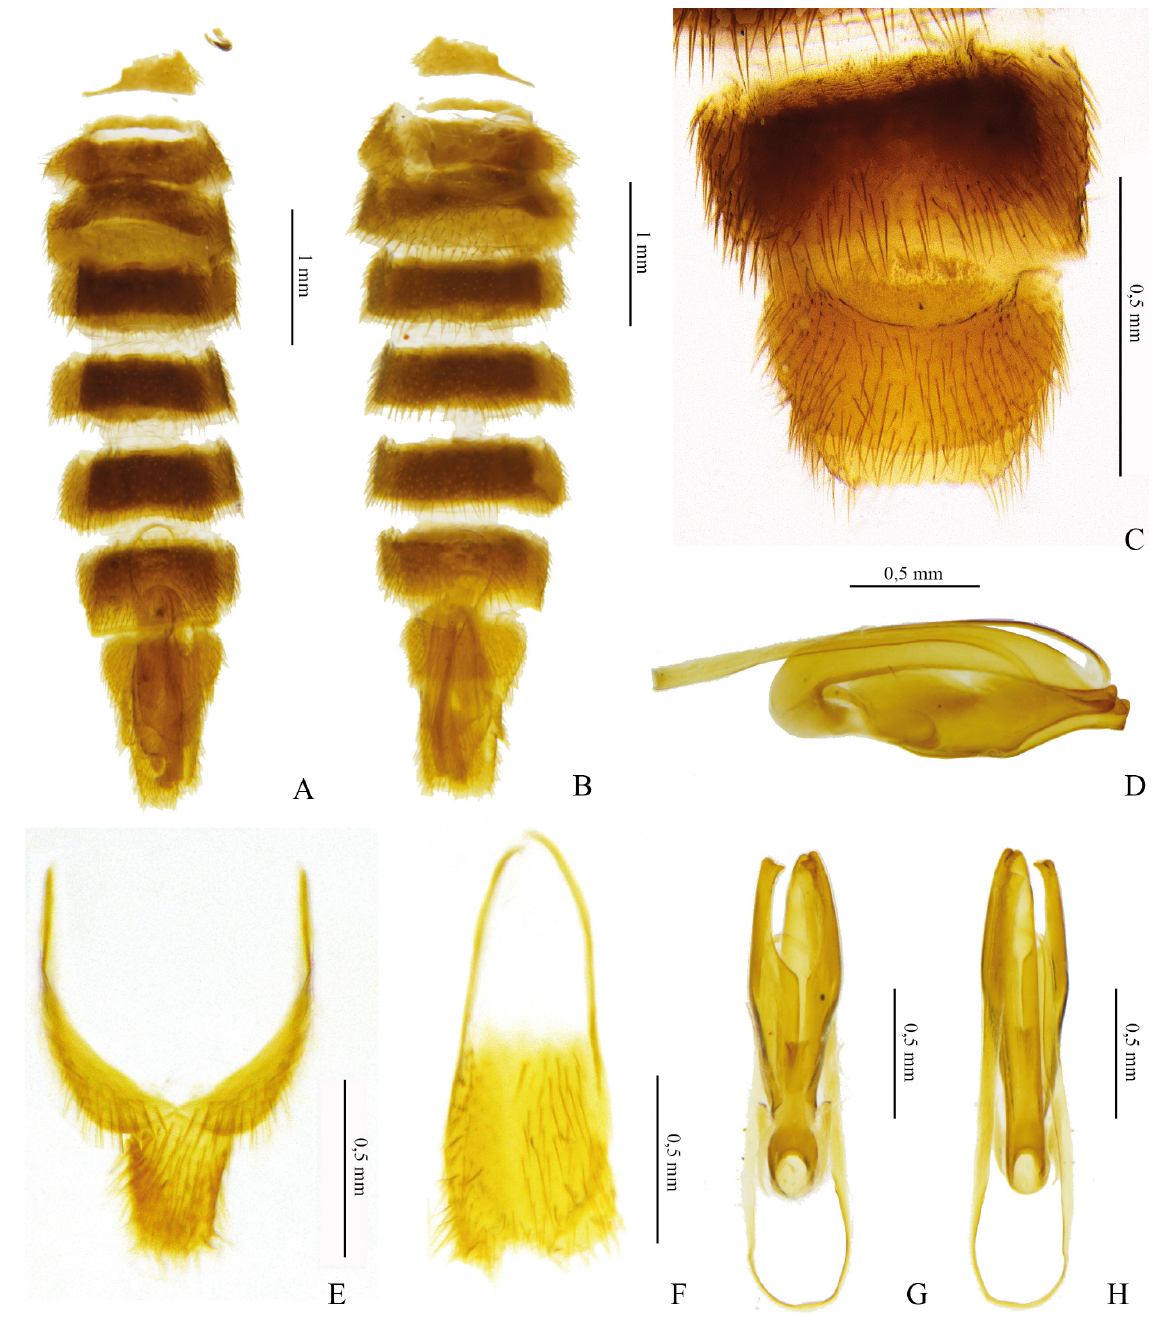
Fig. 4. Iviephengus ferreirai gen. et sp. nov., paratype, ♂ (DZRJ). A . Abdomen, dorsal. B . Abdomen, ventral. C . Sternites VII and VIII, ventral. D . Aedeagus, lateral. E . Tergites IX and X, dorsal. F . Sternite IX, ventral. G . Aedeagus, dorsal. H . Aedeagus,